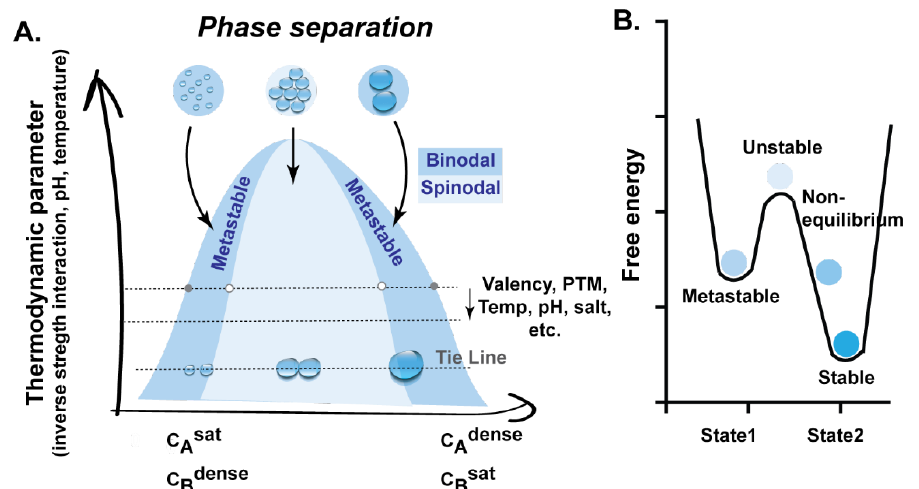
Figure 1. The principles of liquid–liquid phase separation (LLPS) in a binary system. Graphical representation of a phase diagram of a binary system ( A ) and how changes in energy drive the stability/instability of thermodynamic systems ( B ). The conditions leading to LLPS for a binary system composed of molecule A and solvent B (even if the solvent is in itself a mixture such as the cytosol) are depicted in the phase diagram in A. A phase diagram is a graphical representation of conditions (temperature, fraction of concentration of components, pressure, volume, pH, partition coefficient, inverse interaction strength) at which physical states of matter are thermodynamically stable. At very low concentration, A dissolves in B, mixing. As the concentration of molecule A increases, it reaches a point where the solubility of A in B saturates (at CAsat, concentration of saturation of A). Crossing this point, condensates start to form as follows: Molecules A and B can demix into two liquid phases when the binodal or coexistence line is reached. However, for this to happen, in the region between spinodal and binodal lines, a trigger or nucleation event must occur, and a metastable structure is obtained. As the concentration of molecule A increases, and the spinodal line is reached, the trigger is no longer necessary, as the mixture is unstable and spontaneously separates into two coexisting liquids or phases by a process called spinodal decomposition. A further increase in A, CAdense (dense phase concentration of A), passes the upper limit of the binodal line [48]. The mixture is energetically favorable, this time predominant in A. The tie line in the graph connects points of equal chemical potentials. In this line, the size of the droplets increases, but the concentration within the droplet is the same, because the partial molar free energy is equal. To change the molar fractions of CAsat and CAdense, the thermodynamic parameter must be changed. The lower the Csat (concentration of saturation), the stronger the driving forces of phase separation. At the critical point, the mixture is more favorable than the two existing phases [16,48,49]. Abbreviations: temp–temperature, PTM–post-translational